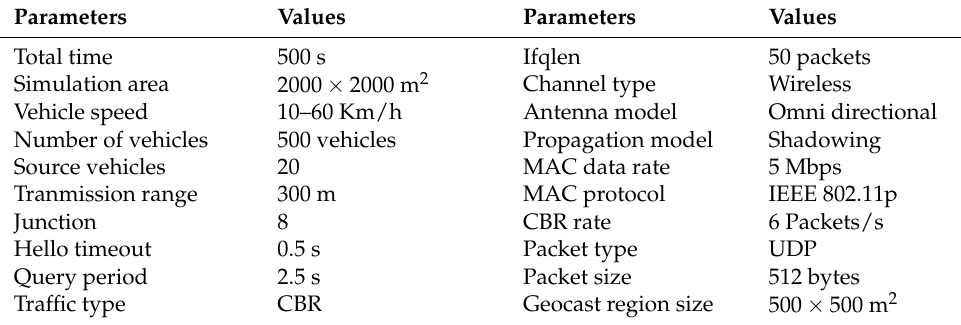
Table 1. Simulation